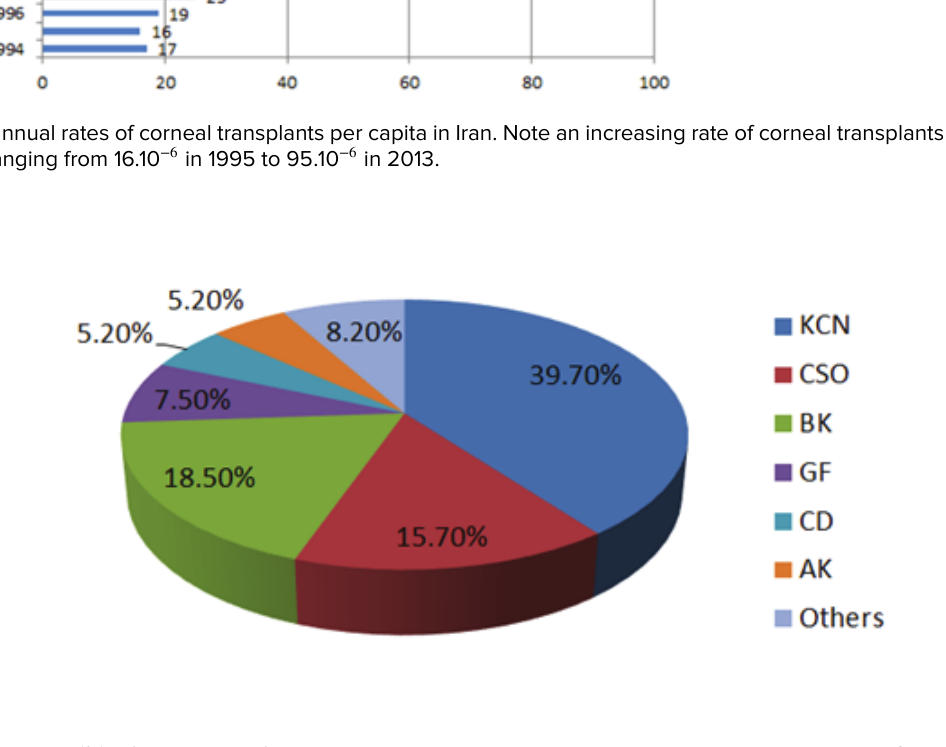
Figure 6. Mean rates (%) of indications for keratoplasty procedures utilizing corneas provided by the Central Eye Bank of Iran. Keratoconus has been the most common indication for keratoplasty (39.70%) over the last 24 years, followed by bullous keratopathy (18.5%), corneal scar and opacities (15.7%), graft failure (7.5%), corneal dystrophies (5.20%), active keratitis (5.20%), and others (8.2%). AK, active keratitis; BK, bullous keratopathy; CD, corneal dystrophies; CSO, corneal scar and opacities; GF, graft failure; KCN,